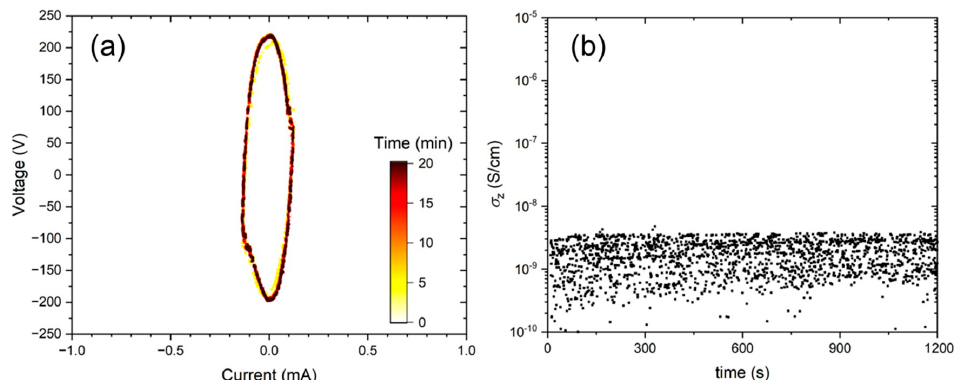
Figure 3. ( a ) Current–voltage characteristic behavior of EVA neat polymer at 160 ◦ C under an alternating electric field of E 0 = 150 V rms /mm and ω AC = 1 s − 1 . Cyclic hysteresis curve suggested that the EVA melt was an insulator and did not undergo dielectric breakdown. ( b ) Through-direction electrical conductivity at sequencer noise level.